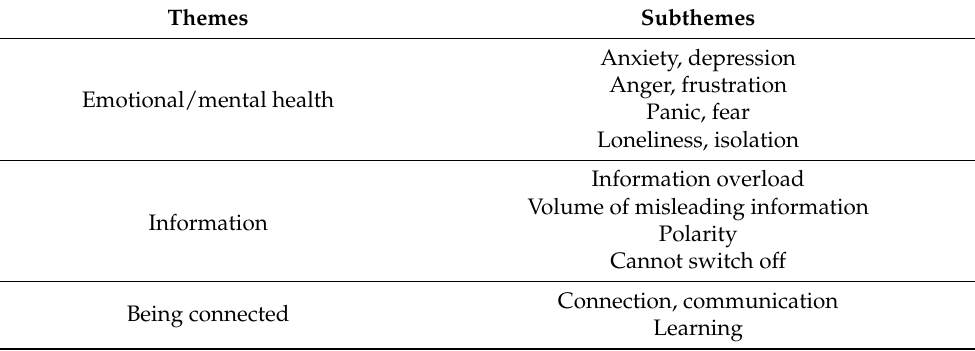
Table 1. Themes and